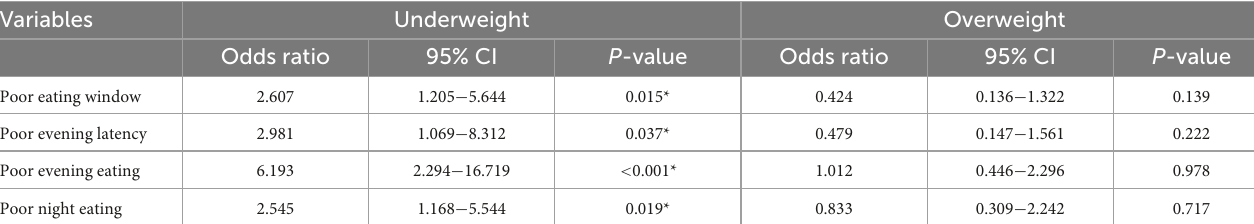
TABLE 5 Predictors of being underweight or